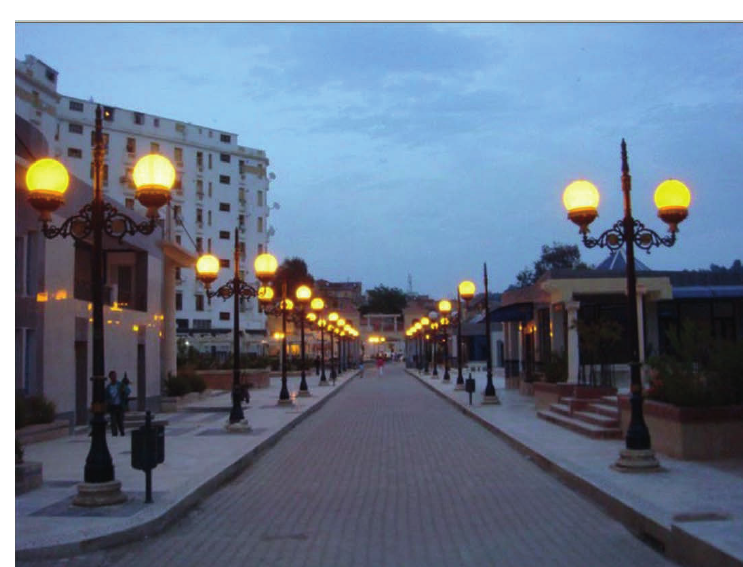
Fig. 8. Pedestrian walkways in the place of Kerkeri (Place Kerkeri, n. d.).